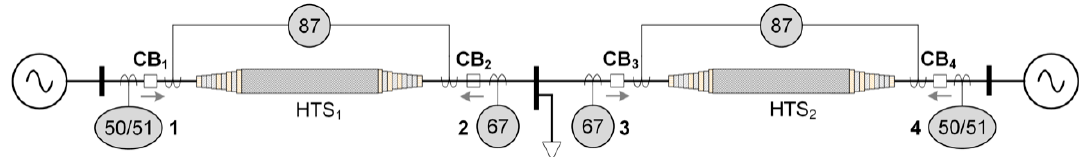
Figure 3. Coordinated protection of the tested system.